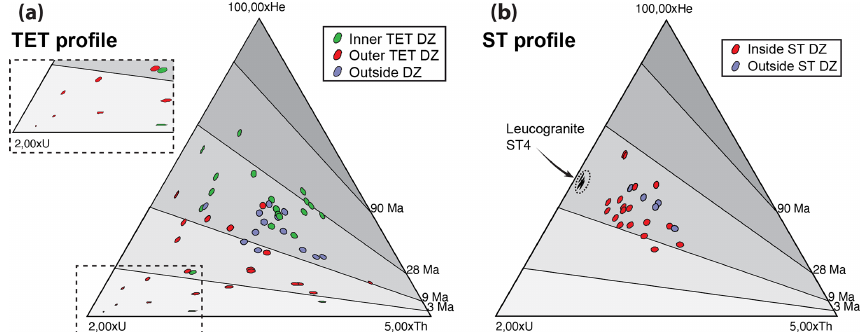
Figure 10. U–Th–He diagrams using Helioplot (Vermeesch, 2010) for (a) TET (this study and Milesi et al., 2019) and (b) ST profile samples (hot spring